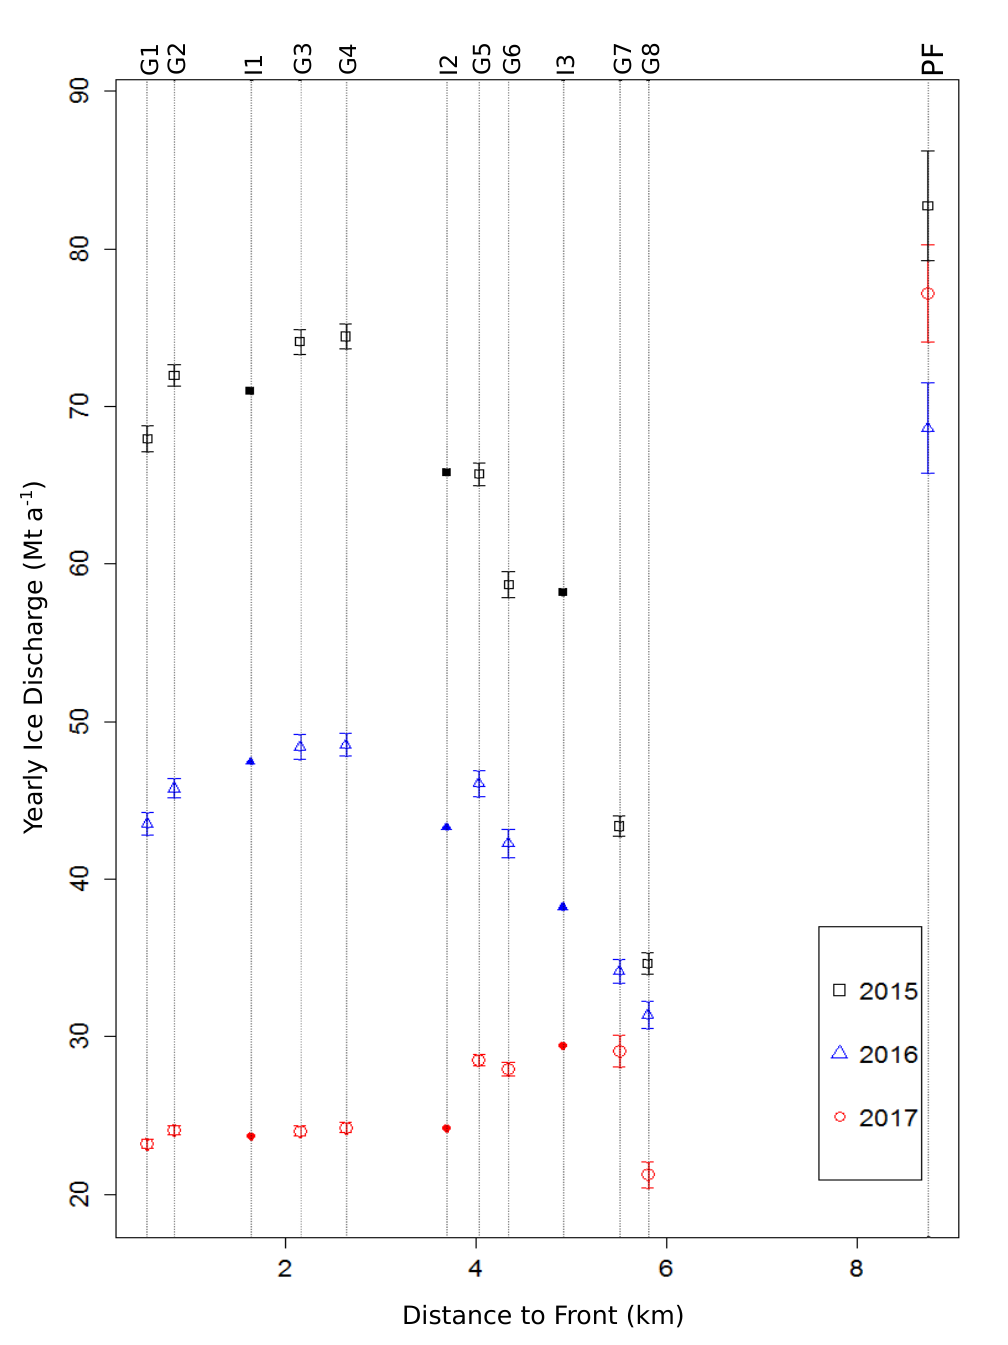
Figure 11. Yearly ice discharge (Mta − 1 ) from in situ (unfilled symbols) and interpolated (filled symbols) data along the distinct flux gates shown in Figure 2a. Ice thickness and the adjacent errors are calculated with data from 2018 and the TIN